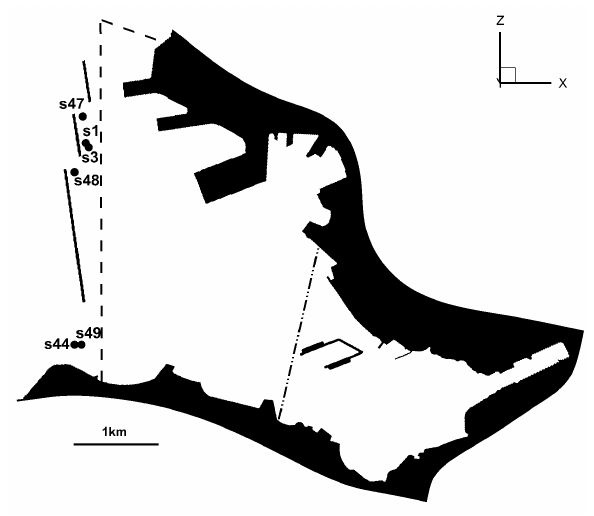
Fig. 9. Top view of the numerical domain. Two regions are defined for the sake of computation of water residence time, as discussed in Sect. 3.3: the outer zone, delimited by the dashed line; the inner zone, delimited by the dashed dot dot line. The black spots indicate the measurement points in the field campaign of Stravisi (1990). Table 1. Wind statistics from data recorded from 12-16 September 2011